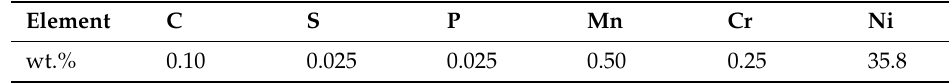
Table 1. Combination of chemical elements (wt.%) in Invar.